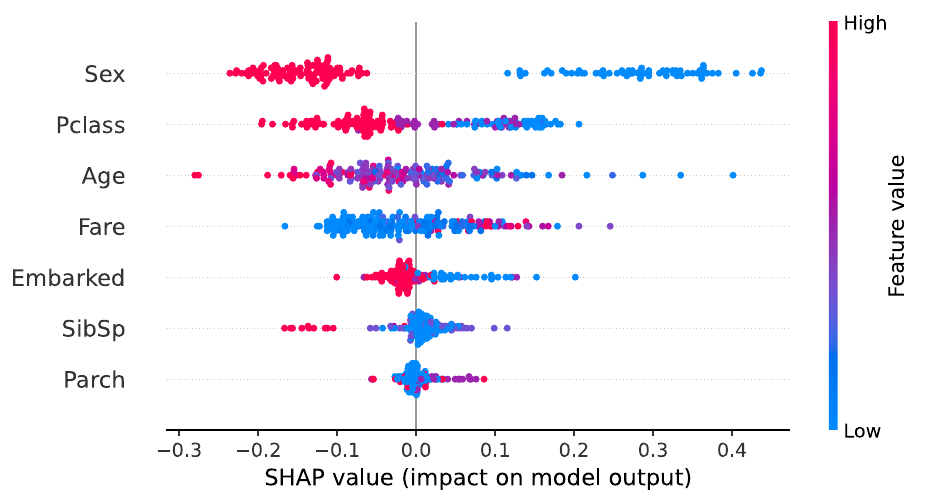
Fig 1. SHAP plot for titanic survival analysis using the random forest